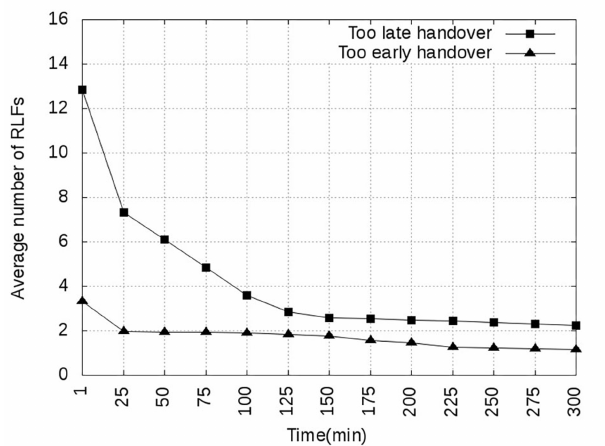
Figure 3. Performance of the proposed optimized HO scheme for late and early HOs,